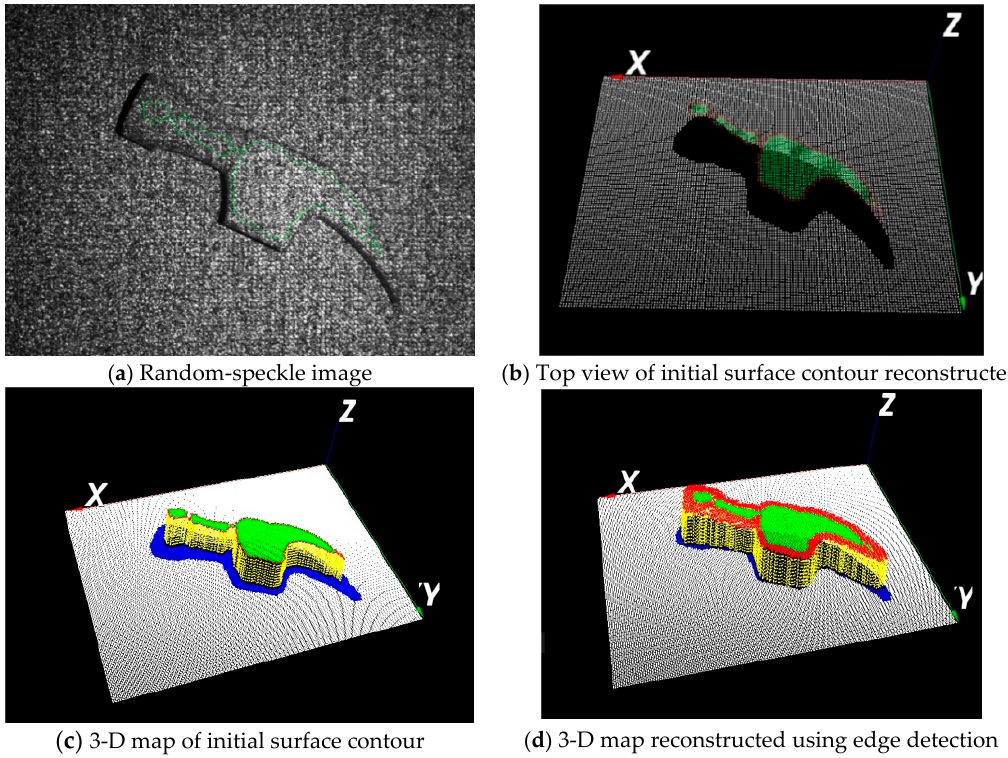
Figure 16. Reconstruction of a 3D-printed hammer using the proposed approach.